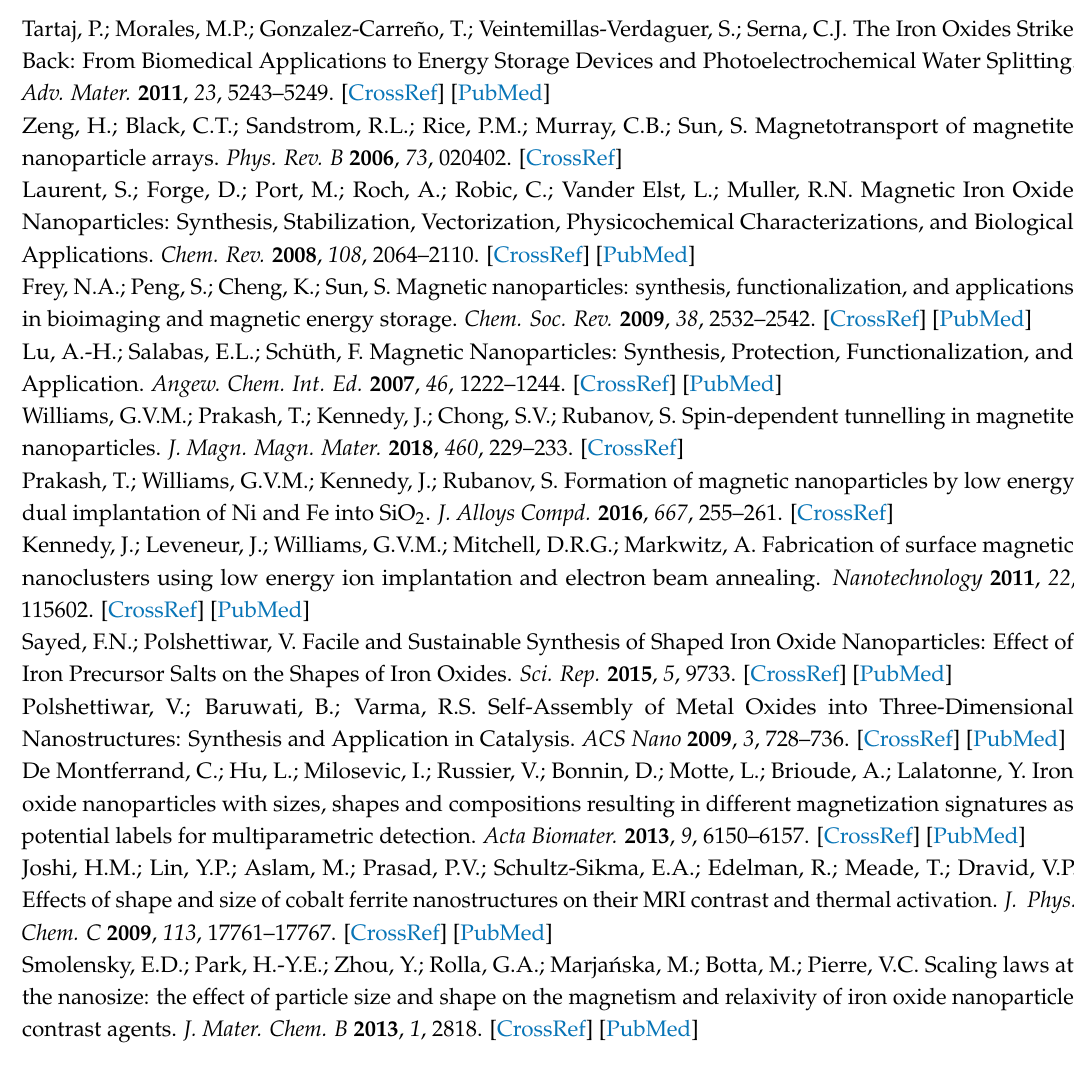
Figure S1: Size distribution of NPs determined from TEM diameter measurement over 300 NPS, Figure S2: TEM images of the decomposition of hydrated FeSt 2 at a NaOl/OA ratio of 50/50 with a heating rate of (a) 1 ◦ C/min and (b) 5 ◦ C/min, Figure S3: XRD refinement of NC15 (a), NPl (b), NO28 (c), IR spectra of NC (blue), NPl (yellow) and NO28 (green) (d) and typical IR spectra of slightly oxidized magnetite and maghemite (e), Figure S4: TEM images of the decomposition of hydrated FeSt 2 at a NaOl/OA Ratio 80/20 (a) 1 ◦ C/min, (b) 5 ◦ C/min and (c) 10 ◦